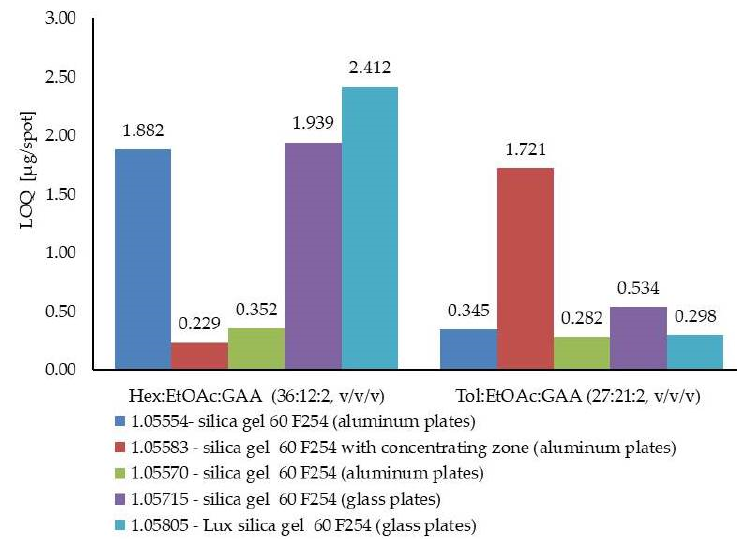
Figure 5. Comparison of average LOQ values of ibuprofen determined by NP-TLC. (Hex = n -hexane, EtOAc = ethyl acetate, GAA = glacial acetic acid, Tol = toluene).